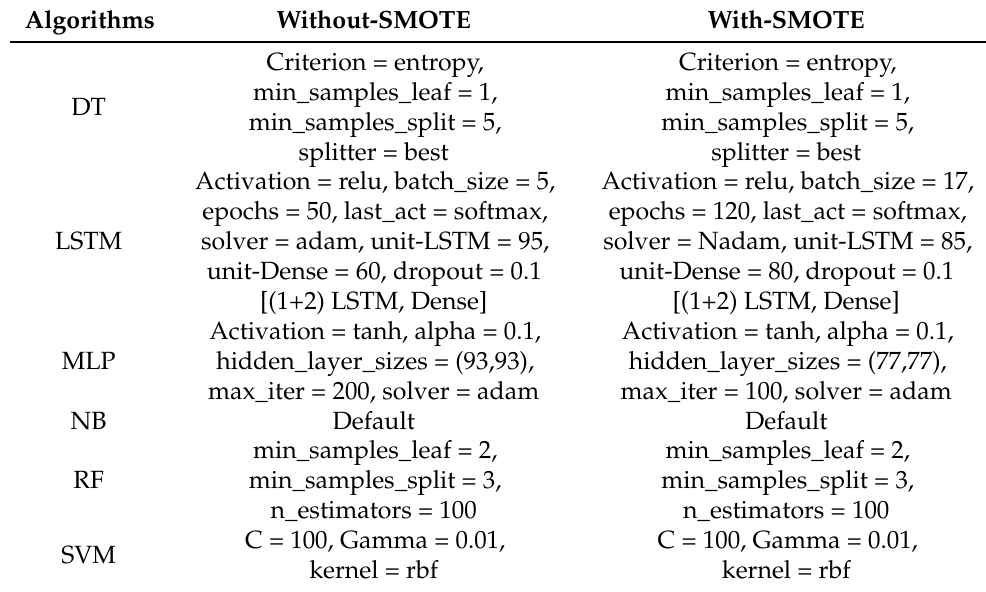
Table 5. Exp2 Scores (Precision, Recall, F1-Score).